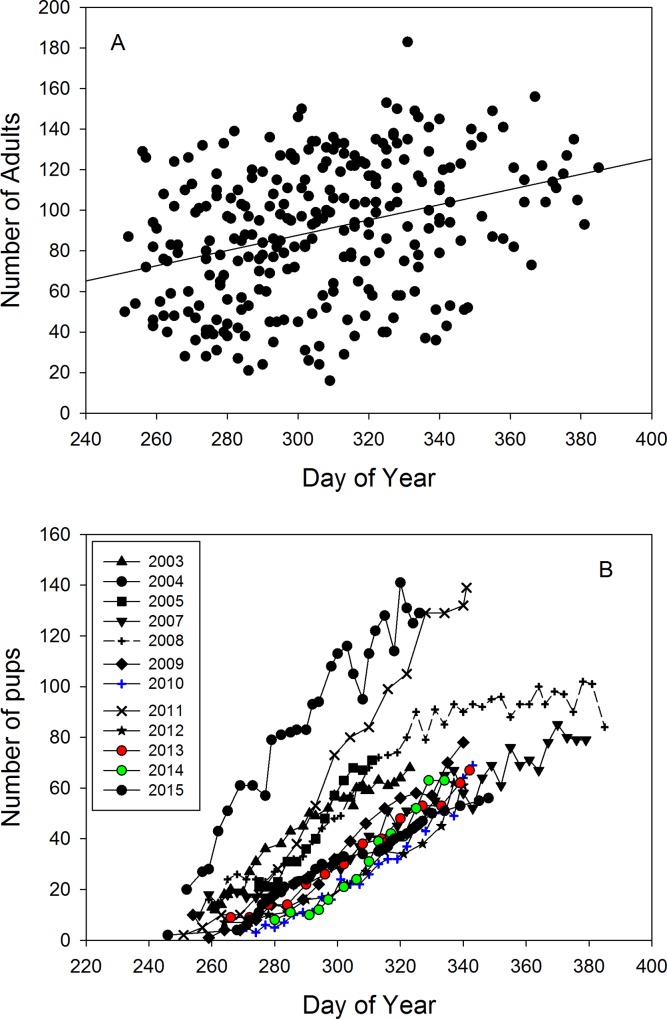
(A) Trend in adult numbers ashore with date (years 2003–2015, without 2006; Jan 1st = day 1) (R2 = 0.158, t = 6.93, p < 0.0001) correlates (r = 0.647, p < 0.001) with (B) the increase in pup numbers with date. Day 240 = 29th of August. In 2007 and 2008 census work extended into January (here graphed as days 366–390) showing the levelling off of pup counts at the end of the reproductive season. No pup census data for 2006.